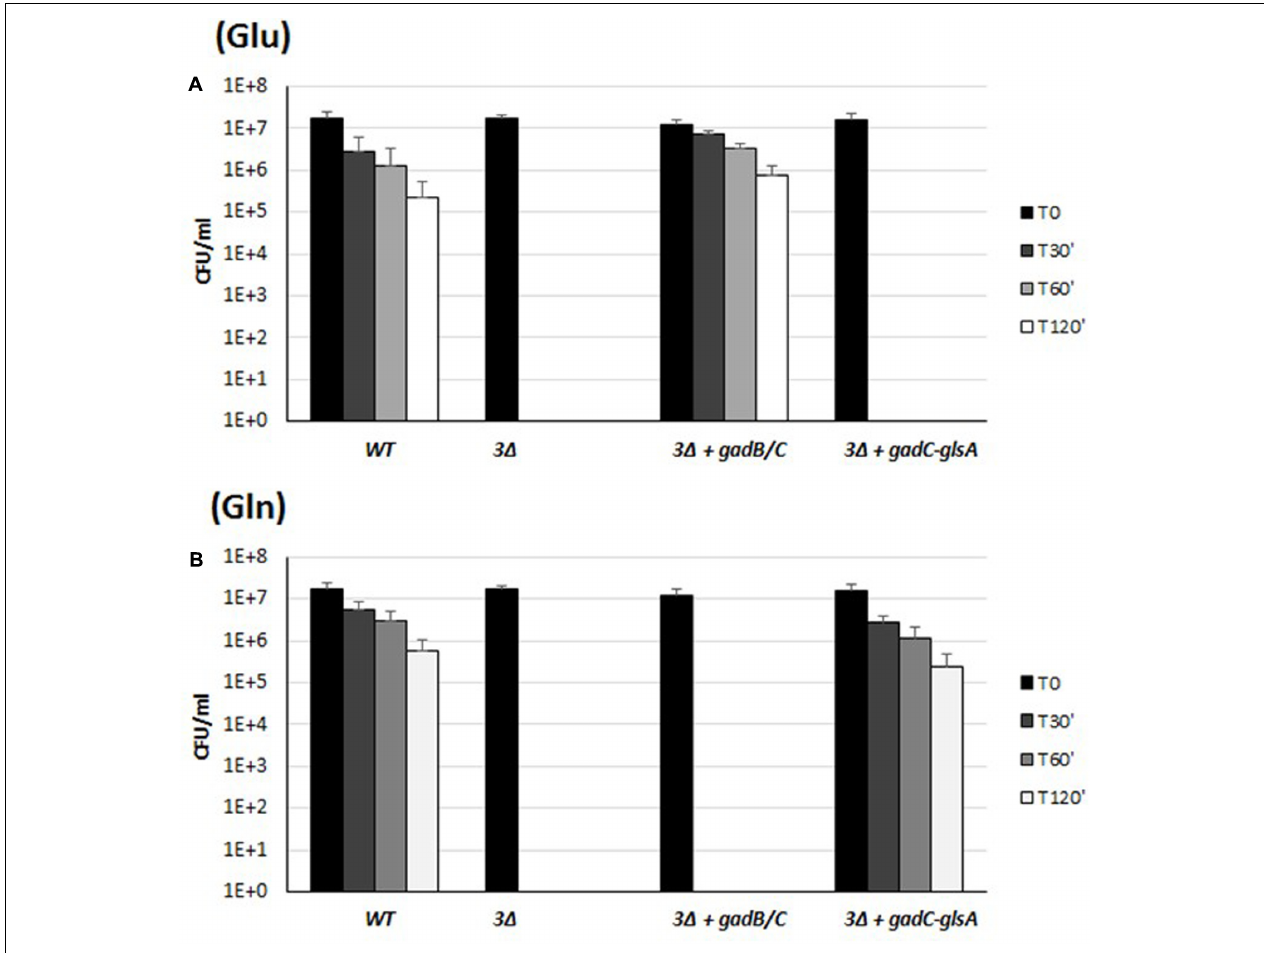
FIGURE 4 | Survival of the wild-type, the triple mutant gadB/C – glsA and the complemented mutant strains of B. microti CCM4915 during extreme acid exposure. Bacteria from stationary-phase cultures in TS at pH 7 were harvested and incubated in modified GMM at pH 2.5, supplemented with 3 mM of Glu (A) or Gln (B) . In the triple mutant strain, indicated as “3 (cid:49) ,” gadB/C – glsA genes were replaced by a Kan R resistance cassette. Mutant strains complemented for the Gad system or the Gln system are indicated with “+” followed by the designation of the relevant genes. Residual viability following the acid shock was expressed as CFU/ml on a log10-scale at each time-point (T30, T60, and T120 min) and compared to unchallenged bacteria present at time T0 (GMM, pH 7.0). No viable bacteria were detected at the same time-points in the absence of Glu or Gln (data not shown). The data represent the mean (SD) of three independent experiments.